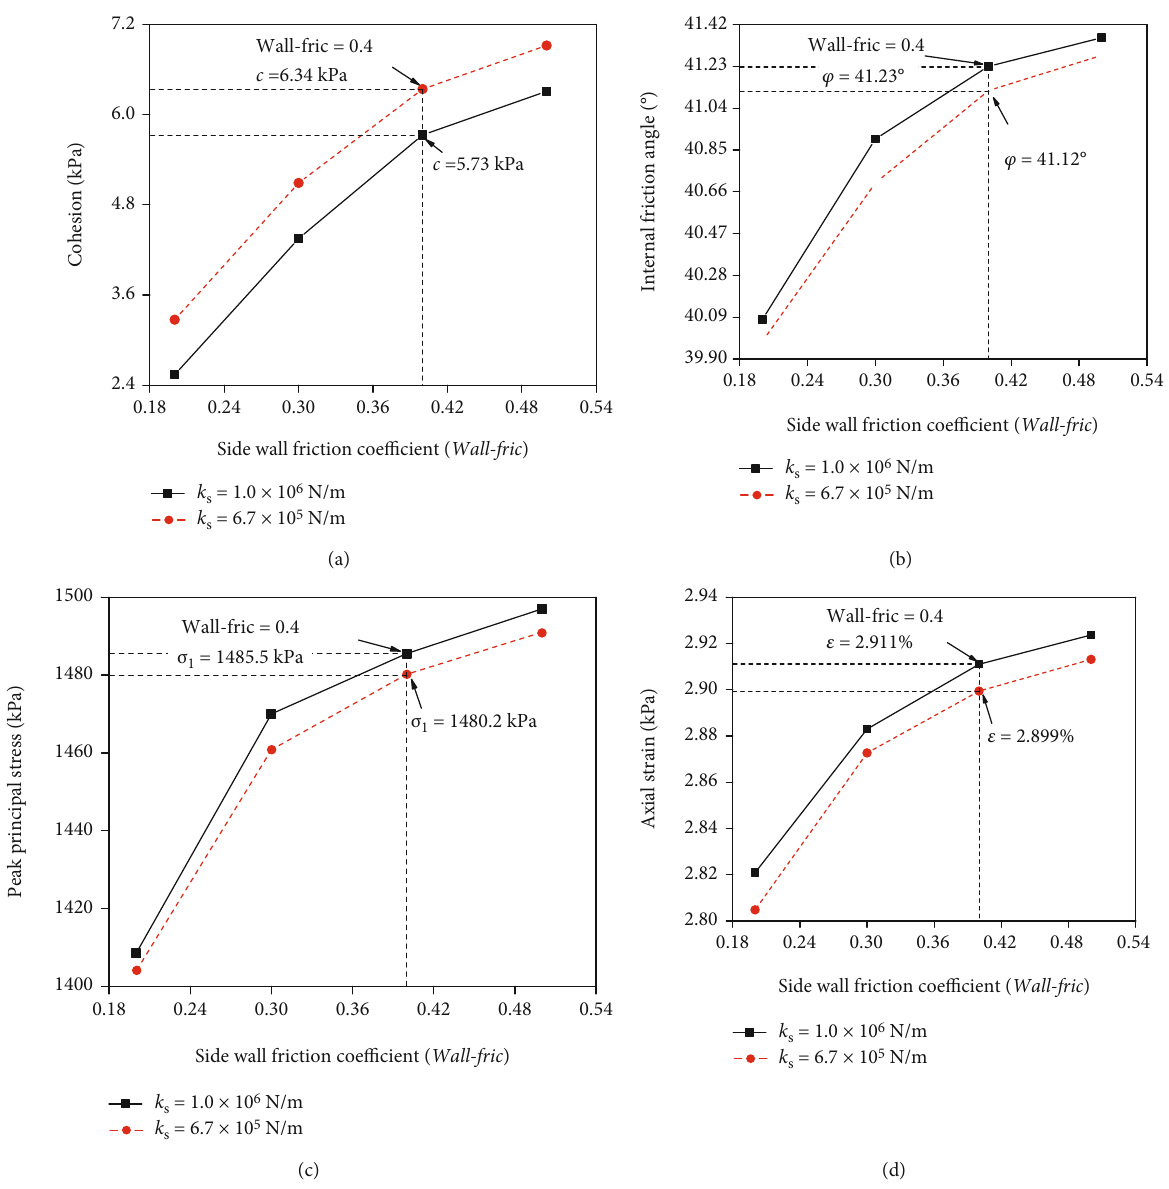
Figure 9: In fl uence of wall-fric on macromechanical parameters: (a) cohesion, (b) internal friction angle, (c) peak principal stress, and (d) axial strain. Table 3: Rate of change of macromechanical parameters a ff ected by changes in mesoparameters. Macromechanical